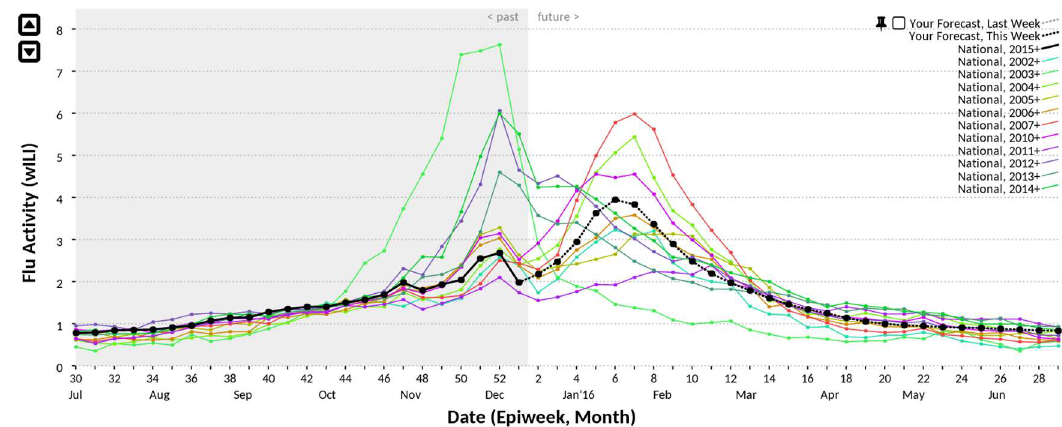
Fig 1. Epicast user interface. A screenshotof the Epicast user interface for predicting flu in the United States. On any given week, the wILI trajectory of the current season (solid black) is only partiallyobserved.A user’s predictionis a continuation of this trajectory over weeks in the future (dashedblack). wILI trajectories of past seasons show the typical course of